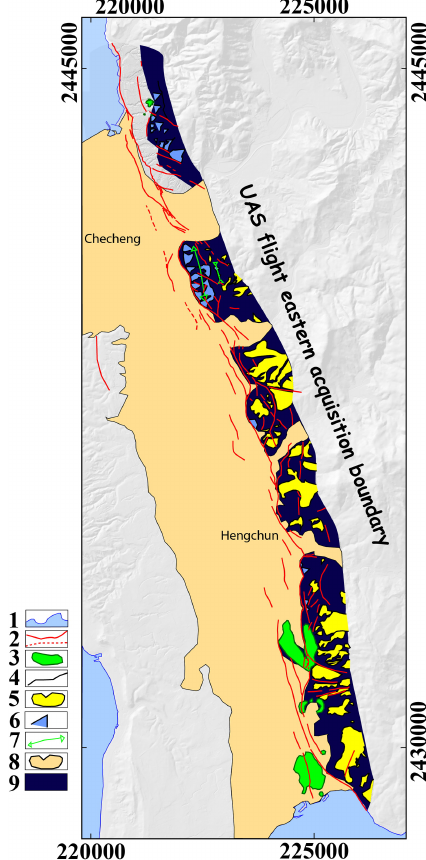
Figure 7. Morphostructural map of the Hengchun Fault: (1) shore- line; (2) faults (red lines: certain faults; red dashed lines: inferred); (3) mud volcano; (4) lithological boundaries; (5) paleosurfaces; (6) chevron corresponding to tilted structural surface; (7) fold axes; (8) Hengchun Valley alluvial and marine deposits; (9) Kenting Mélange. Note that the Hengchun Fault is made of numerous small parallel faults affecting a rather wide area of the eastern Hengchun Valley. It is associated with a N–S-trending fold close to Checheng. Some folds that tilt paleosurfaces and NE–SW, E–W and NW–SE oblique faults affect the Kenting Mélange. The western extension of the Hengchun alluvial plain (8) is deduced from the 5m DTM.